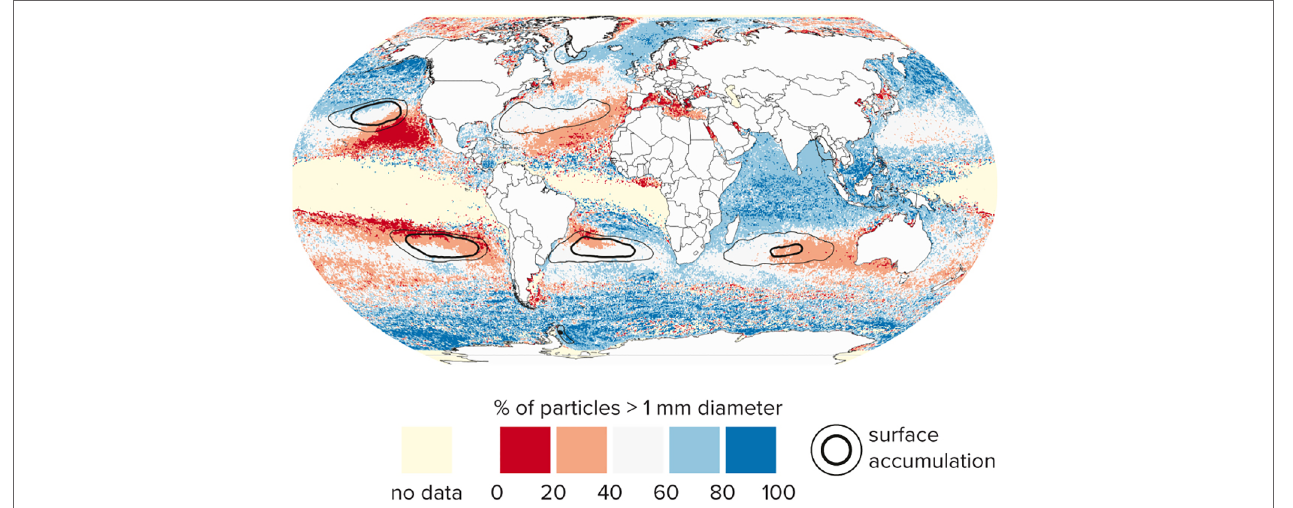
FIGURE 1 | Size sorting of floating plastic particles in the top 10 meters of the global ocean. Distribution is an average over the 20 th model year. Cells with < 5 samples are marked as “no data.” Contours show highest-concentration regions, containing 50% (thin line) and 25% (thick line) of the global particle total, respectively (c.f. Figure 2A ). Diameter is defined as 2 * nominal